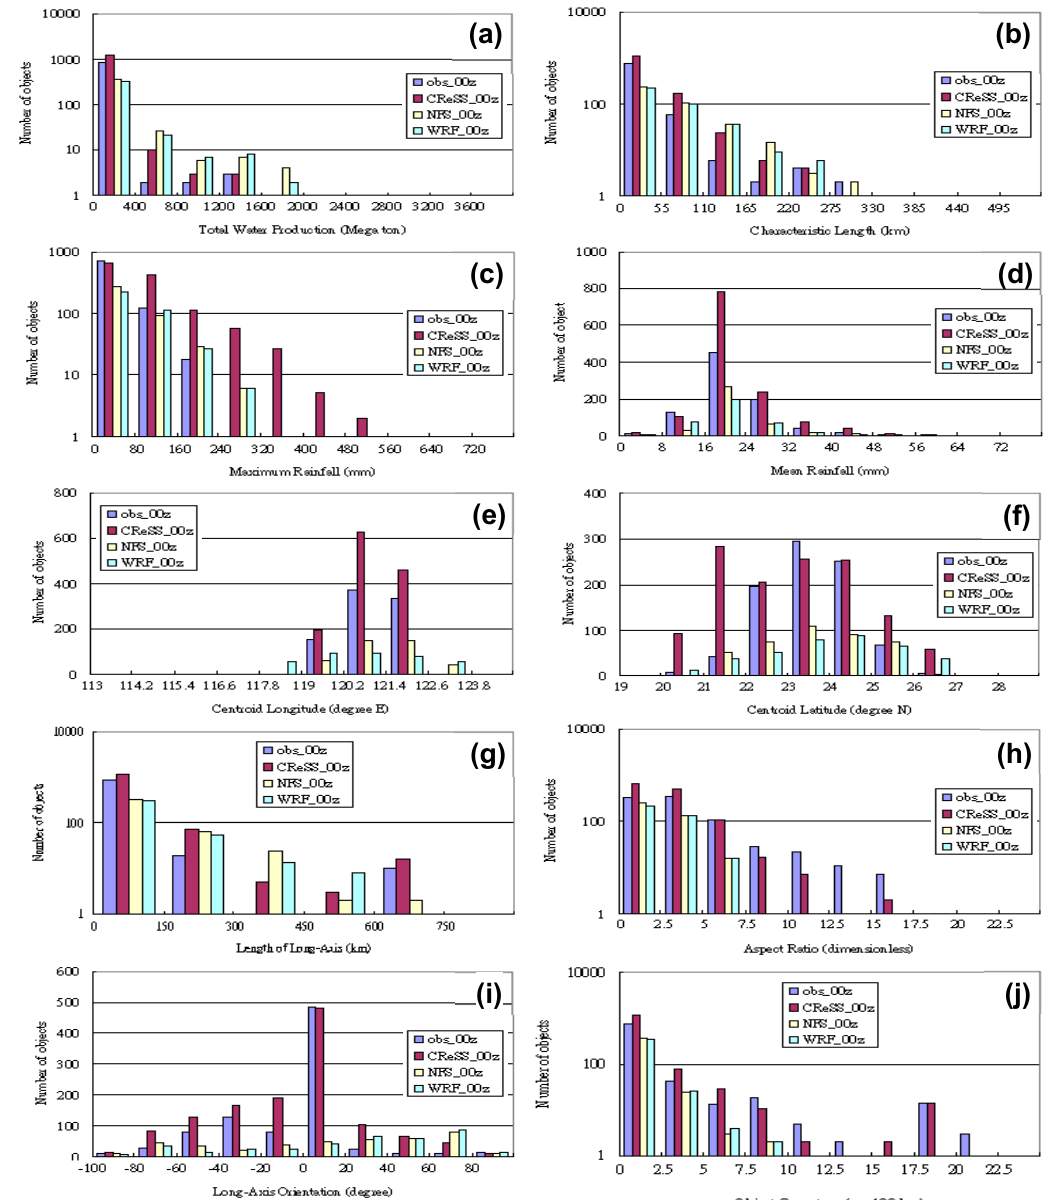
Figure 2. The distribution of number of objects as a function of ( a ) total water production (megaton), ( b ) object characteristic length (km), ( c ) object maximum rainfall (mm), ( d ) object average rainfall (mm), ( e ) centroid longitude ( ◦ E), ( f ) centroid latitude ( ◦ N), ( g ) long-axis length (km), ( h ) aspect ratio (dimensionless), ( i ) long-axis orientation (degree), and ( j ) object curvature (radius per 100 km) in observation and (12–36 h) forecasts by the three models: CReSS, CWB NFS, and CWB WRF initialized at 0000 UTC during SoWMEX. At accumulation period every 6 h, a total of 863 objects are identified in observation, and there are 1287, 371, and 401 objects in forecasts by CReSS, WRF, and NFS, respectively. In panels ( a – c , g , h , j ), the logarithmic scale is used in the vertical axis. To apply the object-oriented verification method, gridded rainfall data [4,5] for a larger area over the oceans surrounding Taiwan were needed, and the TRMM (3B42) data from NASA were employed for this purpose. The TRMM Multi-Satellite Precipitation Analysis (TMPA) [11] provides a calibration-based sequential scheme for combining precipitation estimates from multiple satellites, as well as gauge analyses at feasible locations. The dataset has a resolution of 0.25 intervals and is widely used [11] but is coarser than the gauge data in